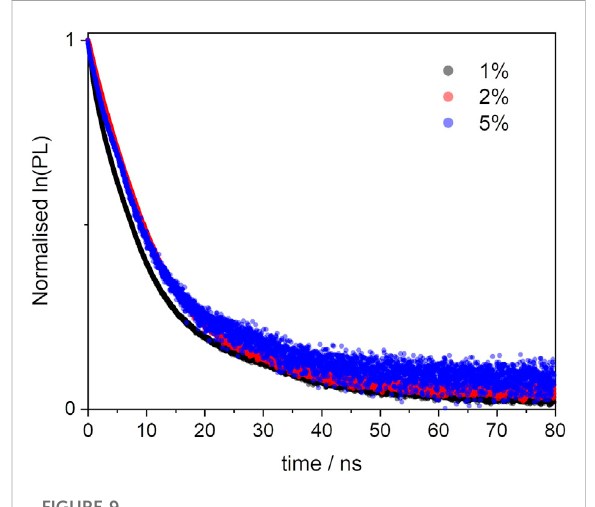
FIGURE 9 Excited state decay pro fi les of the BOPHY2-PMO samples, recorded at λ em = 540 nm, using a 472 nm laser excitation.